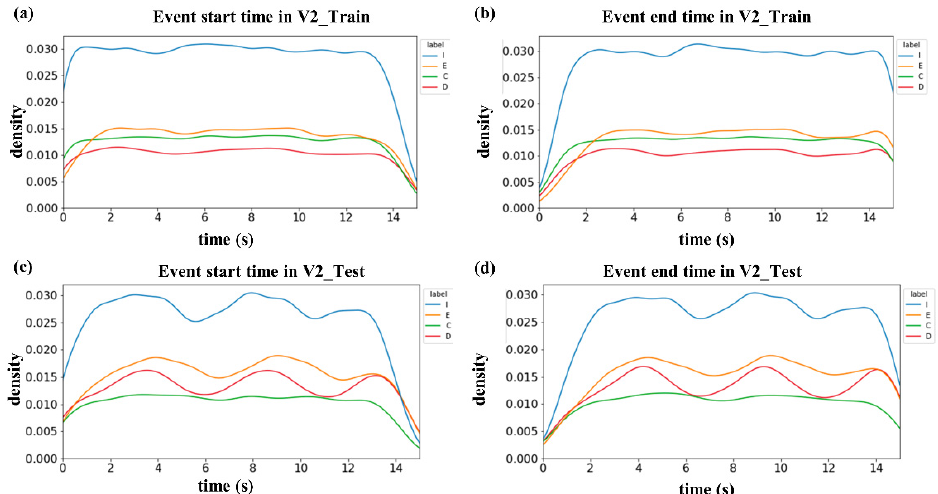
Figure 8. Density plots of the start and end times of the I (blue line), E (orange line), C (green line), and D (red line) labels in HF_Lung_V2. ( a ) Start time in V2_Train. ( b ) End time in V2_Train. ( c ) Start time in V2_Test. ( d ) End time in V2_Test.